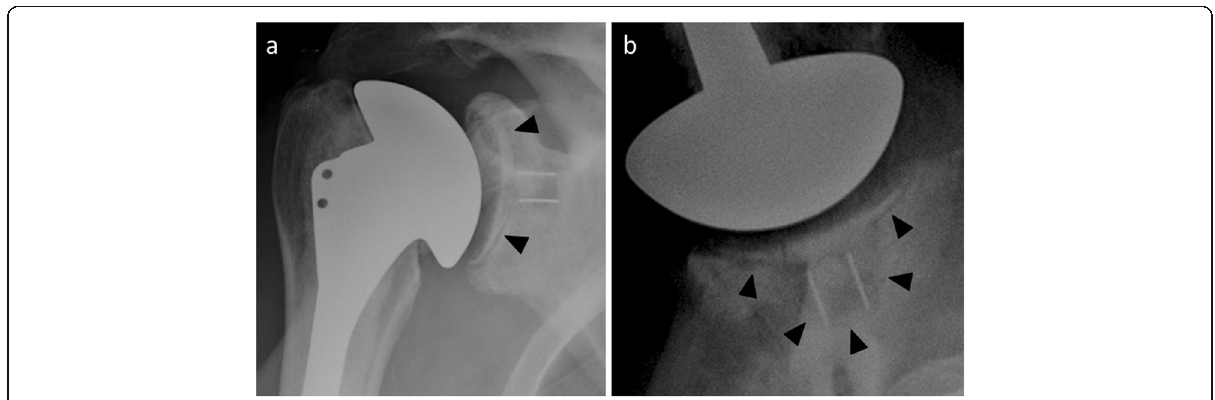
Fig. 16 Anteroposterior ( a ) and axillary ( b ) radiographs in a 66-year-old man with shoulder pain show a complete radiolucent line around